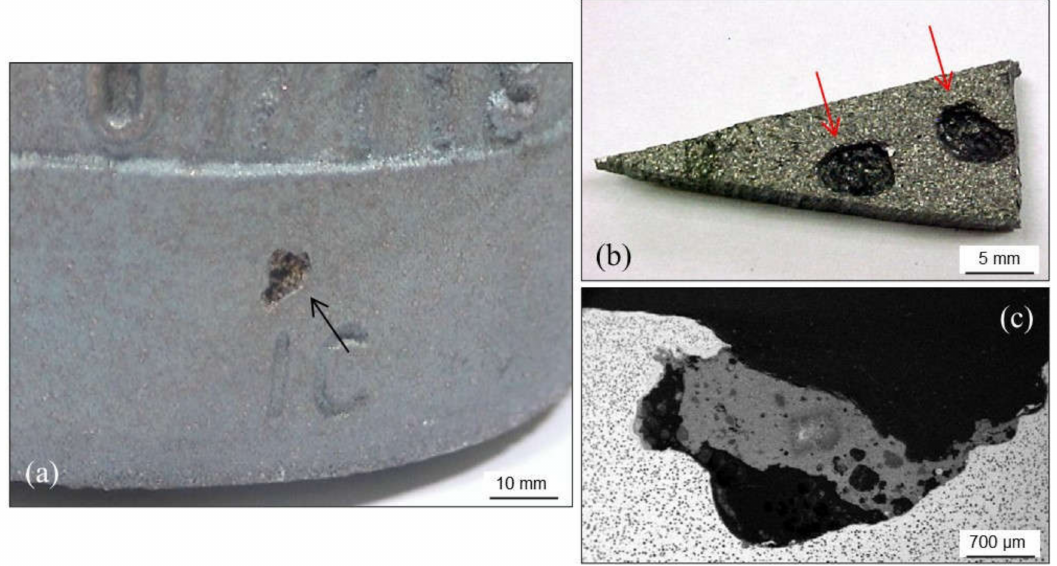
Figure 33. Slag inclusions found in the surface of iron castings ( a , b ). Internal characteristics of a slag inclusion in a ductile iron casting ( c